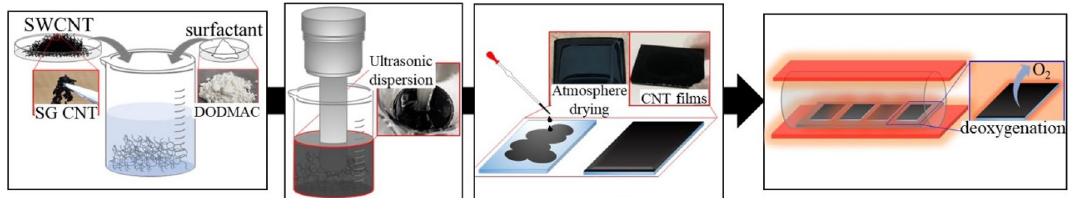
Figure 1. Fabrication process of SWCNT films with